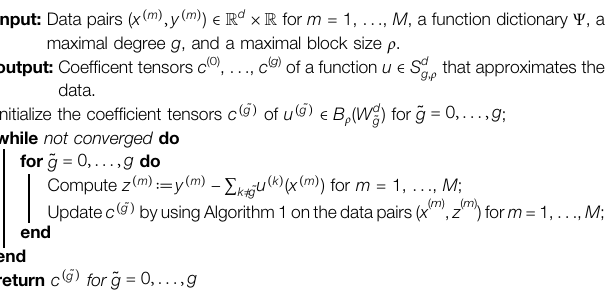
Algorithm 2 | Alternating extended ALS (SALSA) for the least-squares problem on S d g , ρ